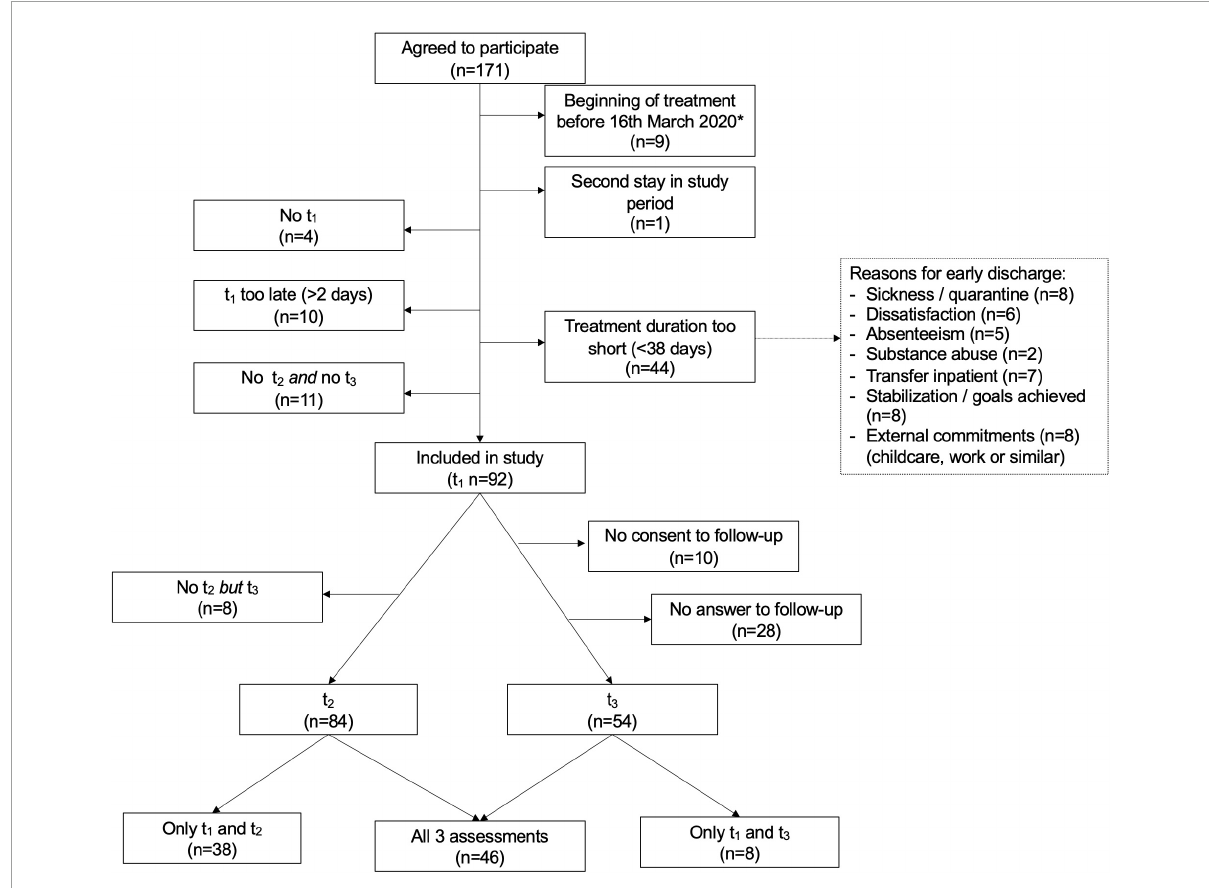
FIGURE1 Flow of participants throughout the study. t 1 , pre-treatment assessment; t 2 , post-treatment assessment; t 3 , follow-up assessment. *16 March 2020: Beginning of Covid-related restrictions in